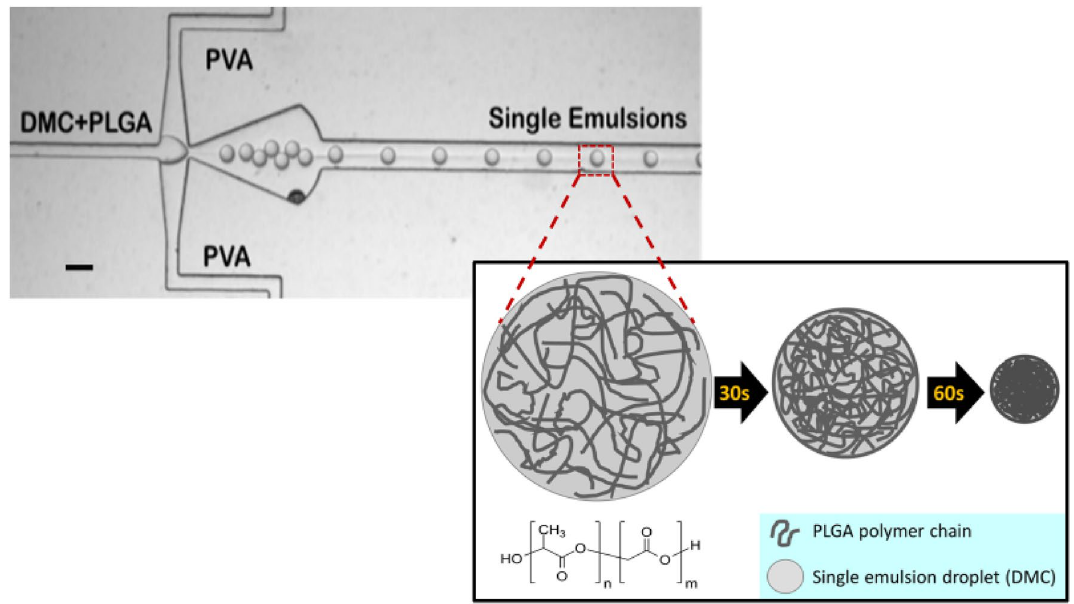
Figure 2. Image of the microfluidic device generating single emulsions (embryonic microparticles). Device design includes one flow focusing junction which creates oil in water (O/W) emulsions by dispersing a PLGA- DMC solution into a 1 wt% polyvinyl alcohol (PVA) continuous phase solution. Direction of flow is from the left to the right. Scale bar is 40 µm. Inset is a schematic of DMC solvent extraction from a single emulsion droplet, yielding one PLGA microparticle. Embryonic microparticles consist of organic solvent, DMC, and PLGA. Complete droplet transformation from an embryonic state into a microparticle occurs after 60